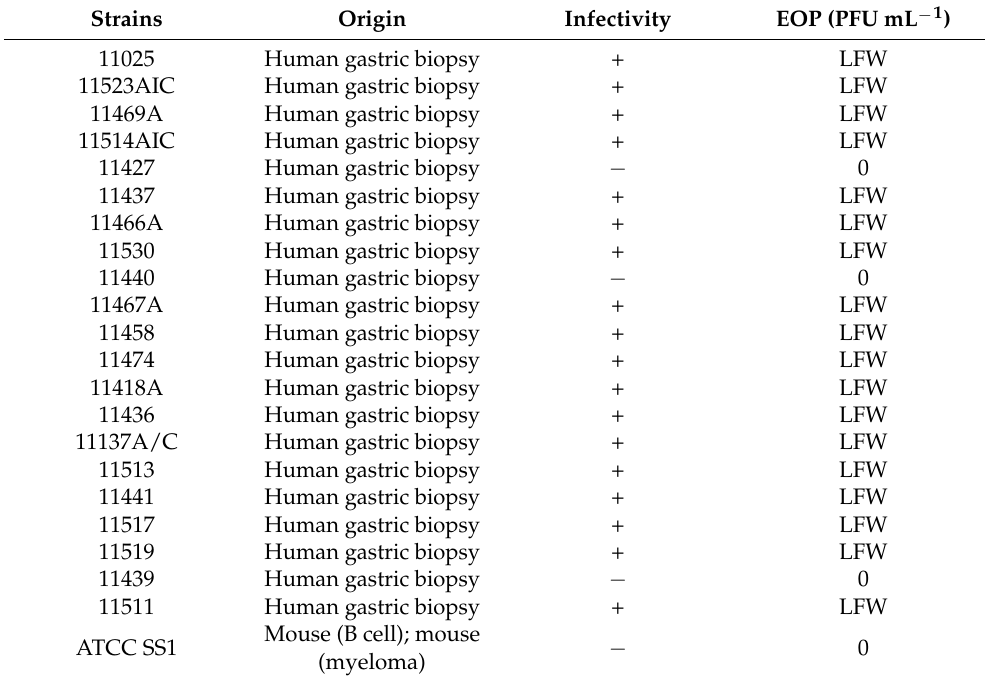
Table 1. Cont. Strains